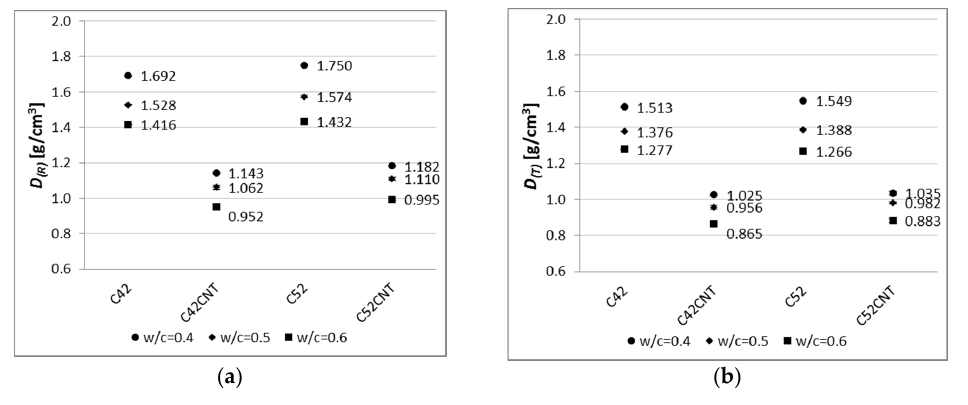
Figure 4. Apparent density of modified cement pastes (error bars mean standard deviations of apparent density; due to the very small values, the error bars are invisible) for ( a ) reference samples; ( b ) samples after thermal load.